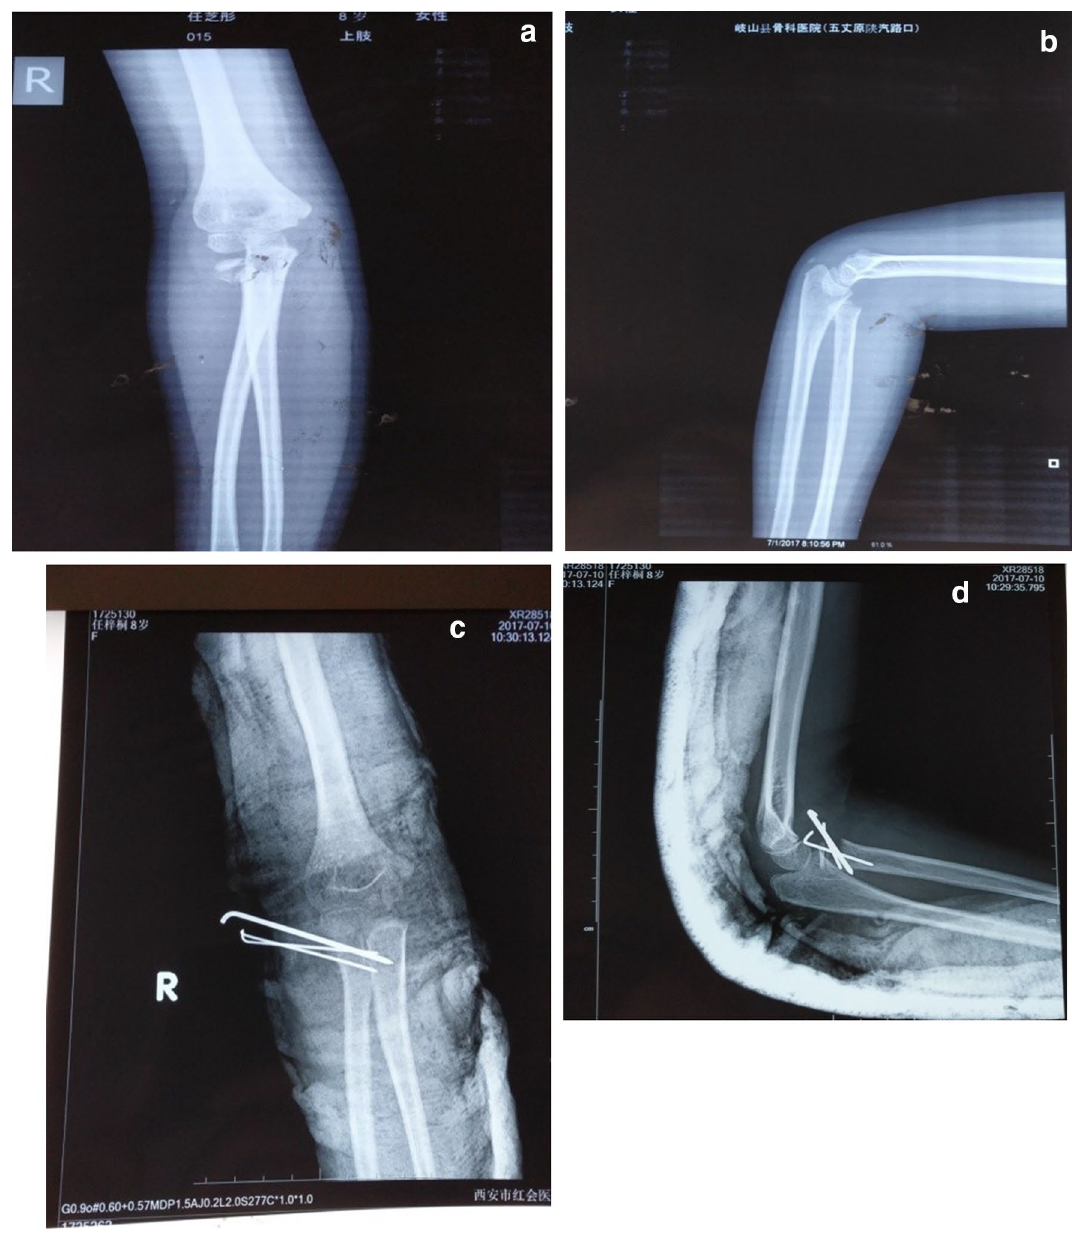
Figure 5. 11-year-old girl, right radial neck fracture, type III, treated with open reduction and fixation ( A ) and ( B ) preoperative, ( C ) and ( D ) postoperative.